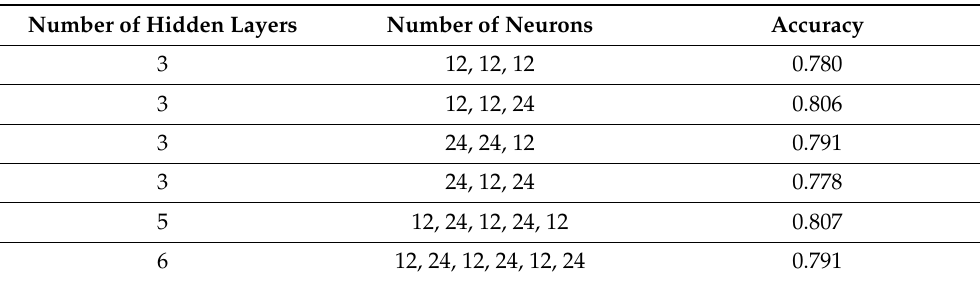
Table 2. The accuracy obtained for various DNN topologies using ‘Relu’ as activation function. Number of Hidden Layers Number of Neurons Accuracy 3 12, 12, 12